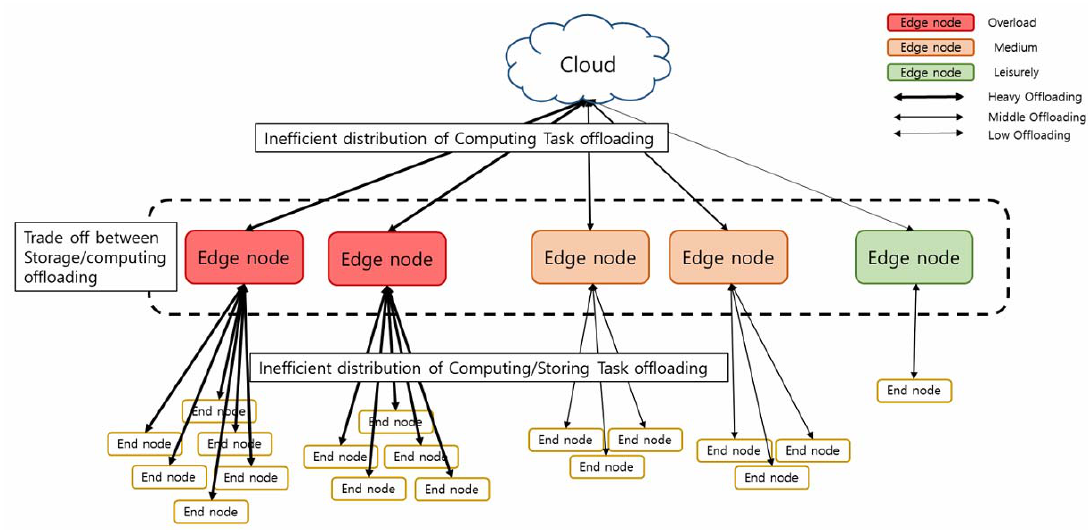
Figure 4. Problems of offloading based on the edge computing.